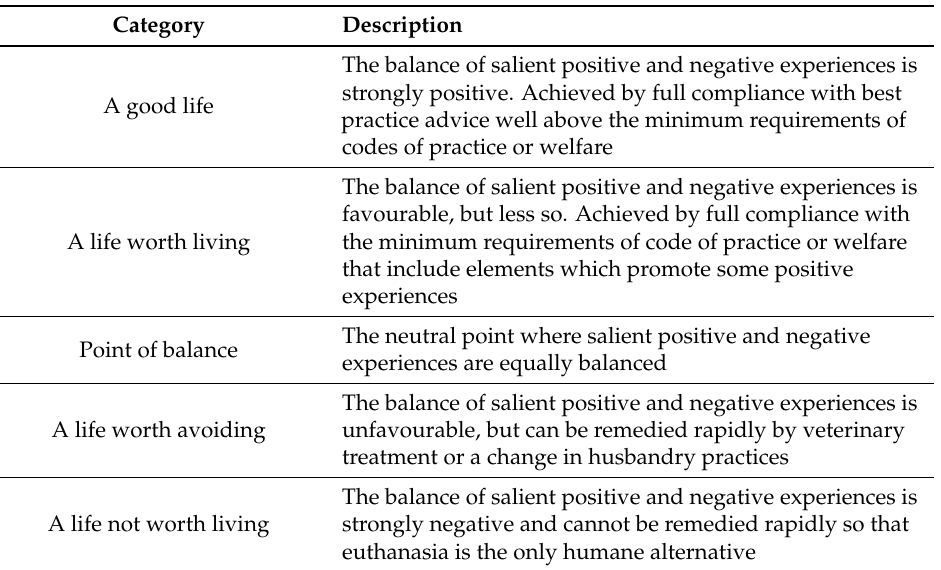
Table 2. A Quality of Life (QoL) scale where the different categories are defined in terms of the relative balance of positive and negative experiences animals may have (adapted from